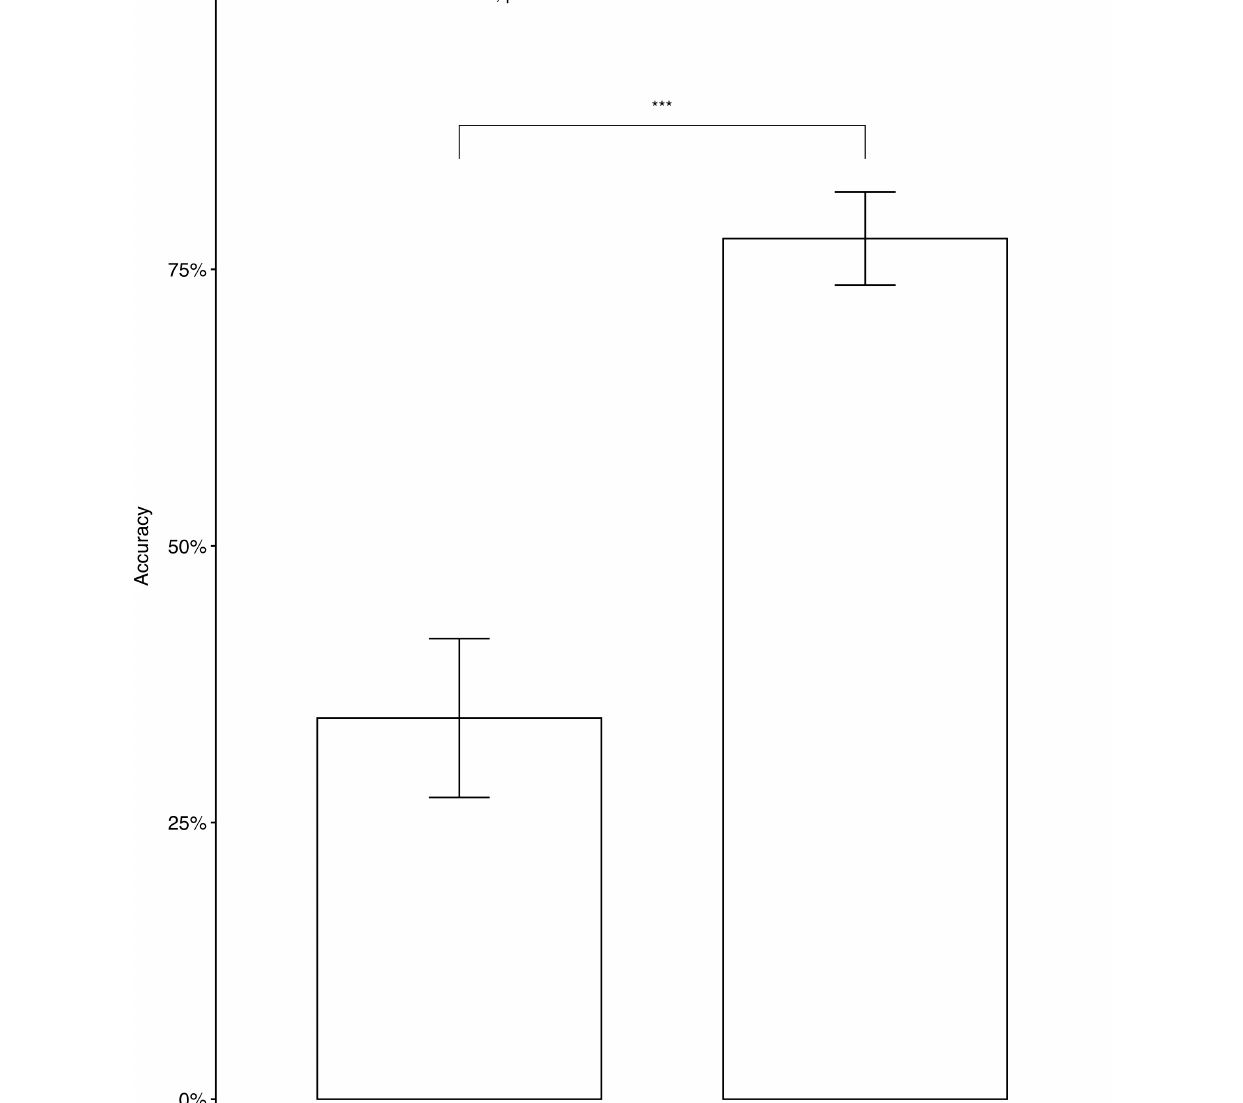
better than left-dominant patterns both by Mandarin and